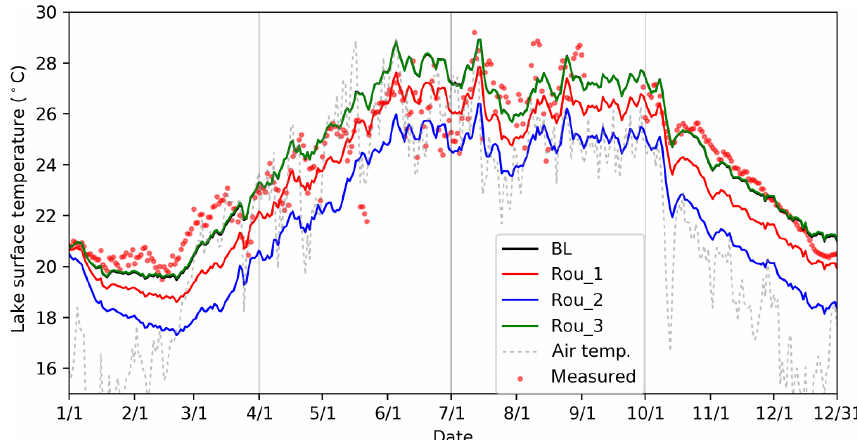
Figure 10. Time series of LST by observation (red dots), BL (black line), Rou_1 (red line), Rou_2 (blue line), Rou_3 (green line), and air temperature (gray dashed line) of Nuozhadu Reservoir in the year 2015. Note that BL and Rou_3 overlap most of the